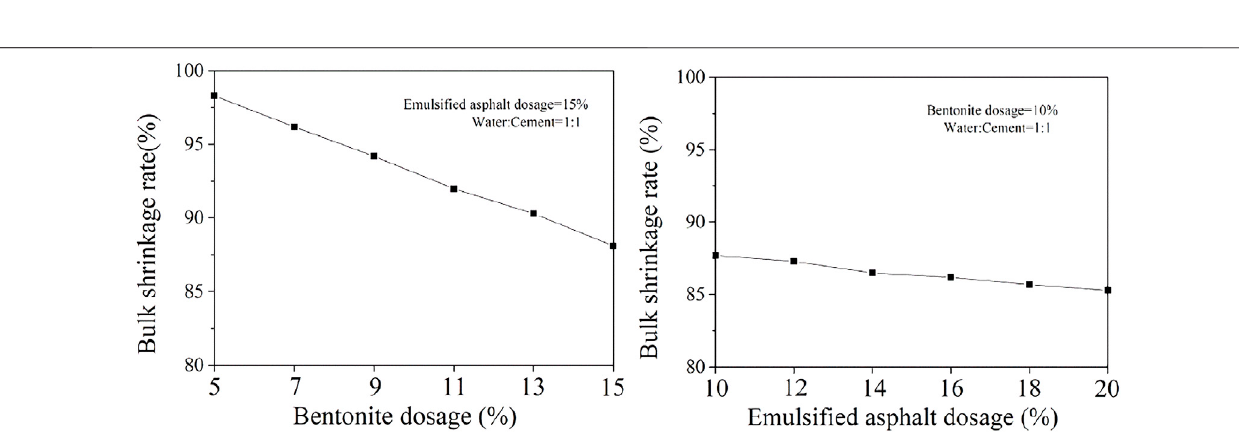
FIGURE 5 | In fl uence of the bentonite dose and emulsi fi ed asphalt dose on the bulk shrinkage rate of CACG.